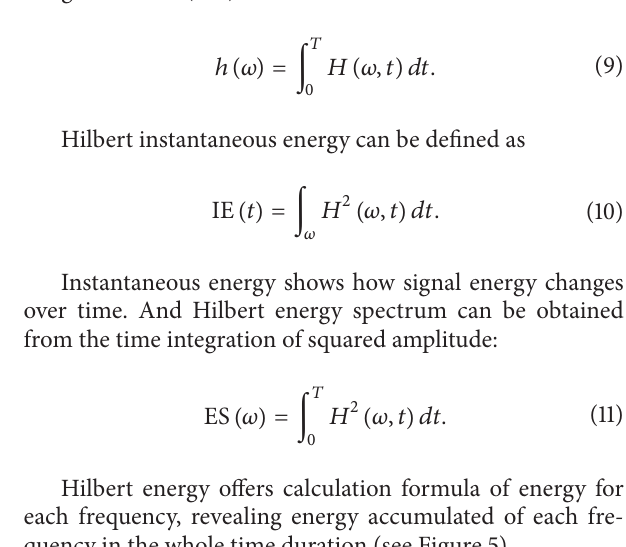
Hilbert marginal spectrum can be obtained from the time integration of 𝐻(𝜔, 𝑡)